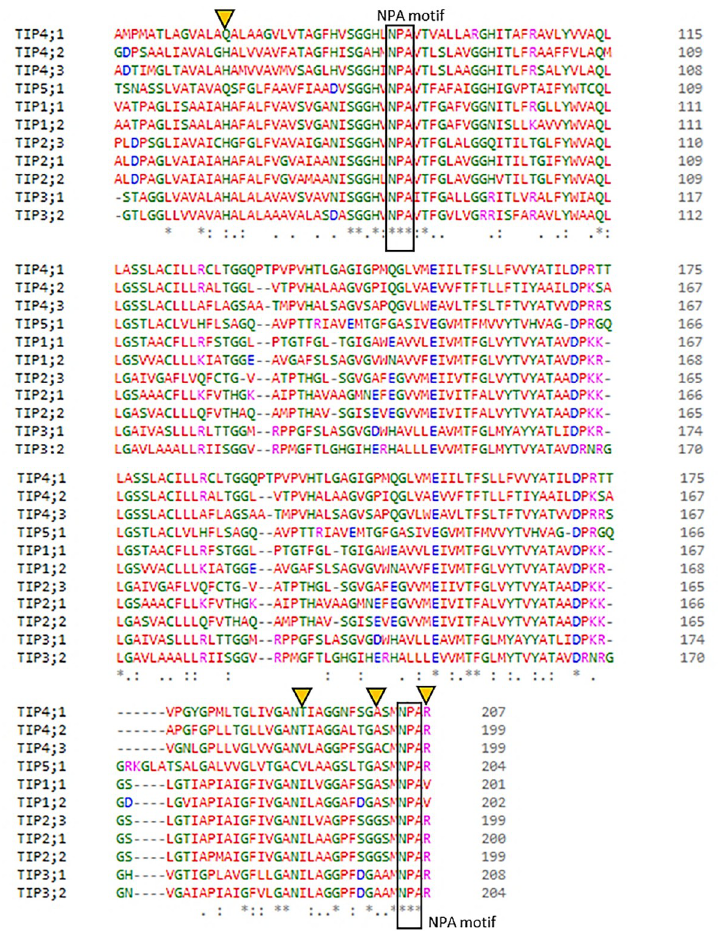
Fig 3. Multiple sequence alignment of partial amino acid sequences of HvTIPs in barley. NPA motifs and ar/R selectivity filters were labeled with rectangular boxes and yellow triangles, respectively. (Fig 1). After the drought treatment, the plants were re-watered for 14 days. Control seedlings